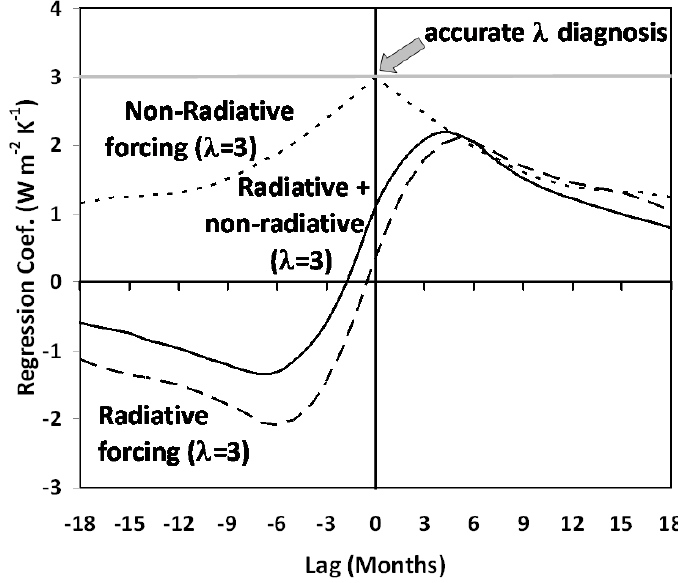
Figure 4. Lag regression coefficients between temperature and radiative flux from the simple forcing-feedback model run for three forcing cases: pure non-radiative forcing (dotted line); pure radiative forcing (dashed line); and a 70% radiative/30% non-radiative forcing mixture. A feedback parameter of 3 W m − 2 K − 1 and ocean mixing depth of 25 m were specified for all three simulations, which each ran for 500 years of simulated